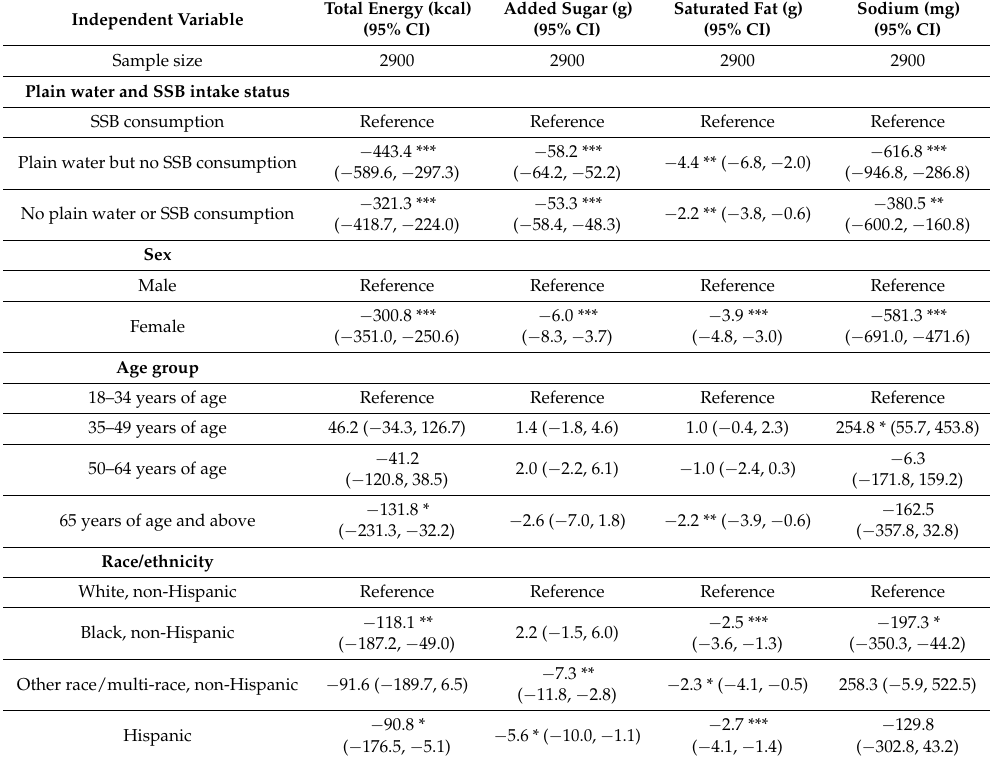
Table 3. Adjusted differences in daily energy and nutrient intake at full-service restaurants by plain water and sugar-sweetened beverage (SSB) consumption status, 2005–2012